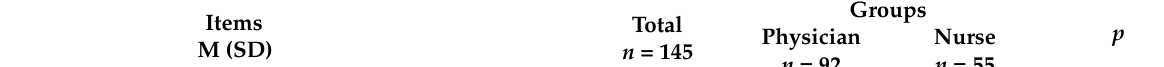
Table 6. Descriptive statistics of the questions about consolidation of learning, the applicability to the position at work, and the need for additional